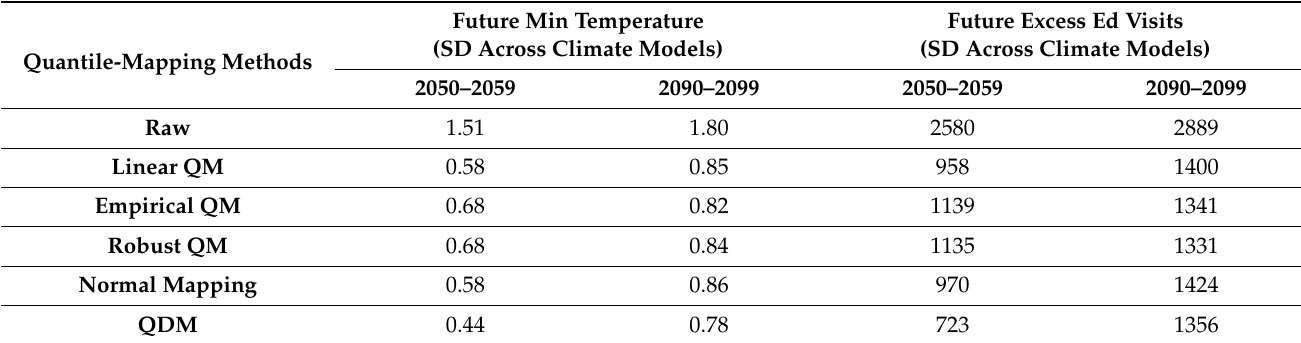
Table 3. Average between-model standard deviation (SD) for projected daily minimum temperature and excess emergency department (ED) visits in Atlanta between May and September for two projection periods. Statistics were first calculated across days within each climate model and then across 10 models from NA-CORDEX.